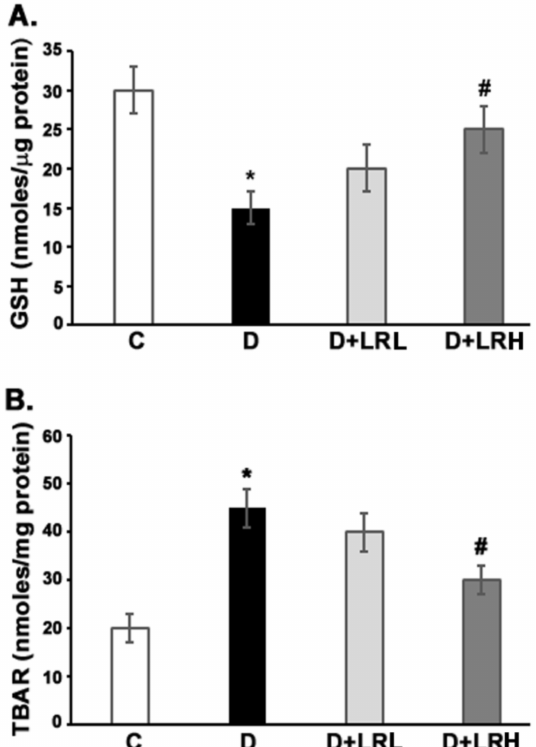
Figure 5. Antioxidant effects of L. regularis in the retinas of diabetic rats. GSH levels in all treated and untreated groups were compared as shown in panel ( A ). Similarly, the levels of TBARS in the L. regularis -treated and untreated groups were compared as shown in panel ( B ). The values are means ± SEM (n = 6). (* p < 0.01, vs. diabetic; # p < 0.05, vs. controls). (C) stands for control, (D) for diabetic, (LRL) low-dosage L. regularis , and (LRH) high-dose L. regularis . Experiments were carried out